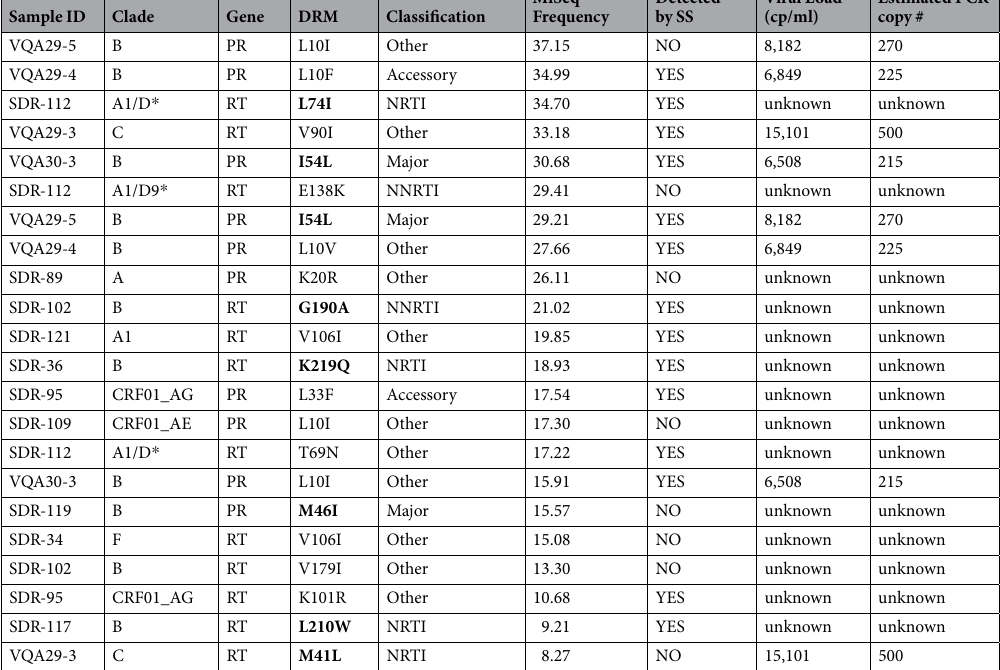
Table 3. Comparison between the MiSeq-HyDRA platform and SS for detection of HIVDR-related mutations near the conventional 20% threshold. SDRMs are shown in bold . Another 75 mutations at frequencies 1~8.13% that were not detected by SS were shown in Supplementary Table S3. * Recombinant assignments are based on PR/RT sequence